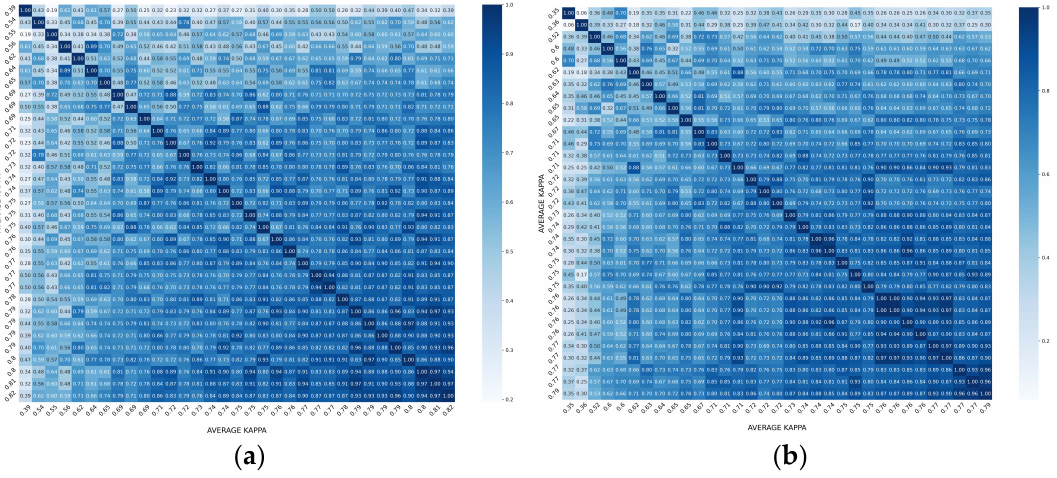
Figure 3. Cohen’s kappa between raters for ( a ) longitudinal acquisitions and ( b ) transversal acquisitions classifying patients into 4 subgroups according to their total score. Raters are sorted from left to right based on their overall Cohen’s kappa with their peers (indicated by the axis ticks).